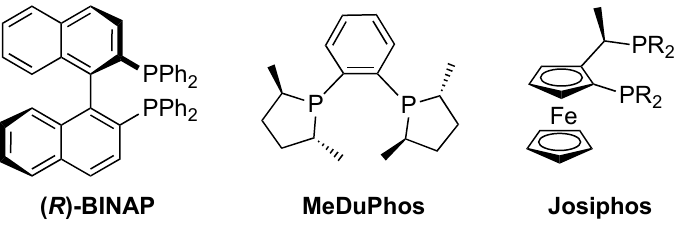
Figure 1. Examples of privileged P,P ligands.